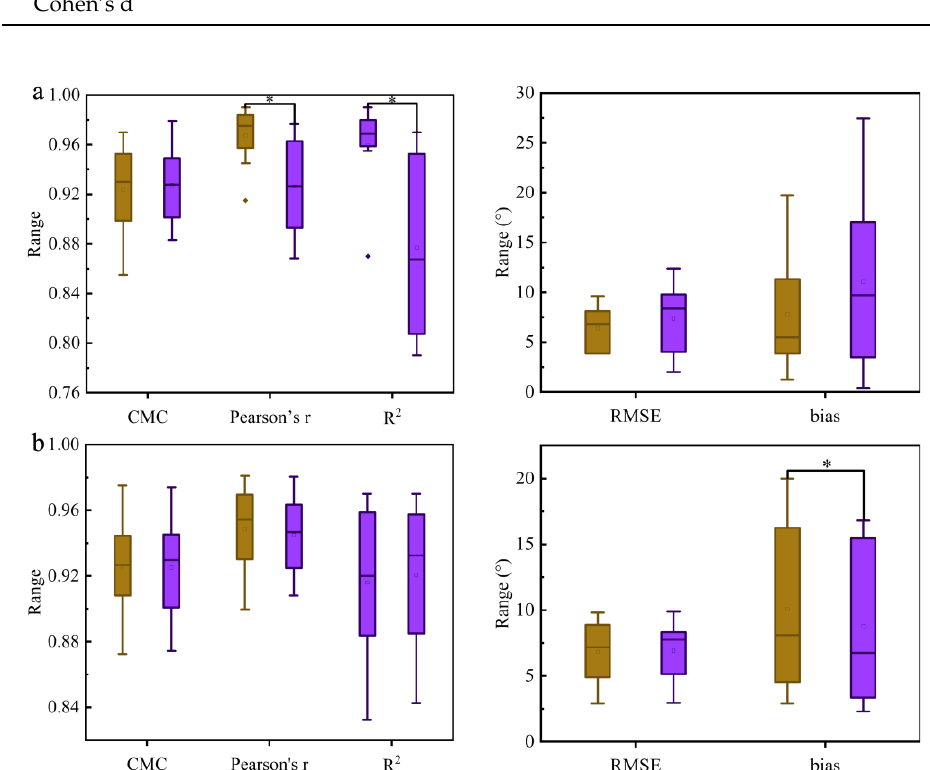
Figure 4. Box-and-whisker plots of the validity metrics (i.e., CMC, Pearson ‘ s r, RMSE, and bias). ( a ) simple (brown) and complex (purple) tasks. ( b ) Fast (brown) and slow (purple) speeds. Note that ∗ represents 𝑝 < 0.05.